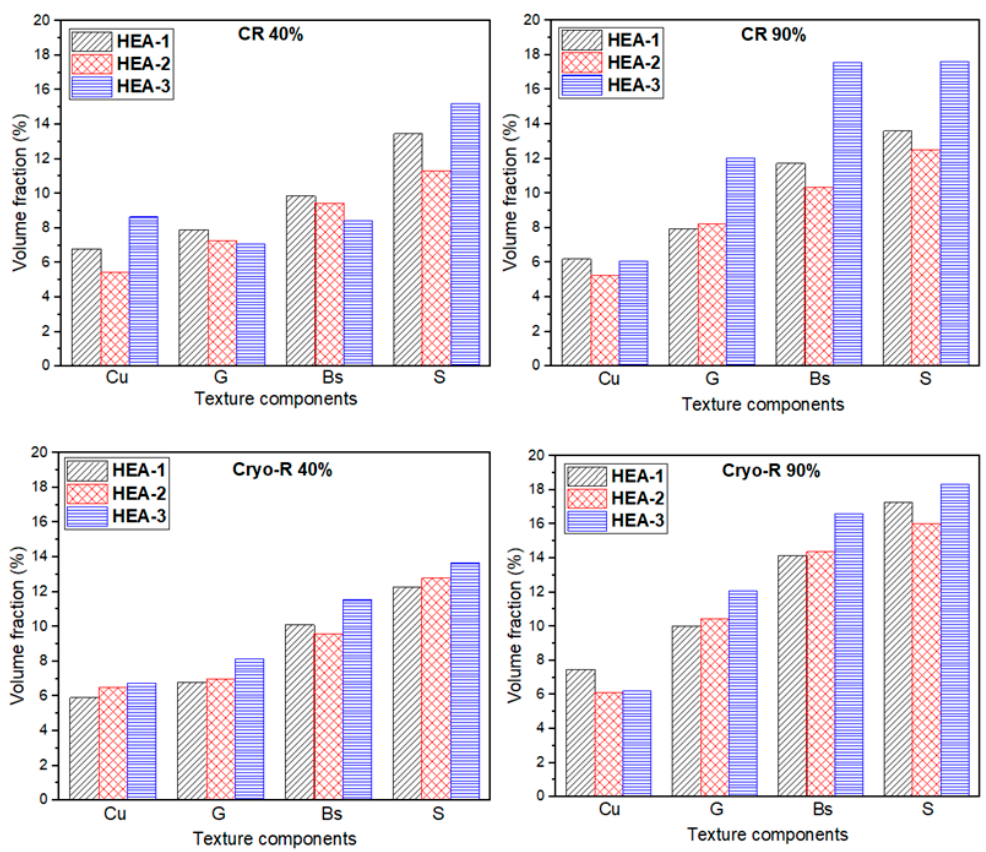
Figure 7. Volume fractions of the main texture components of 40% and 90% cold-rolled (CR) and cryo- rolled (Cryo-R) HEAs 1–3.